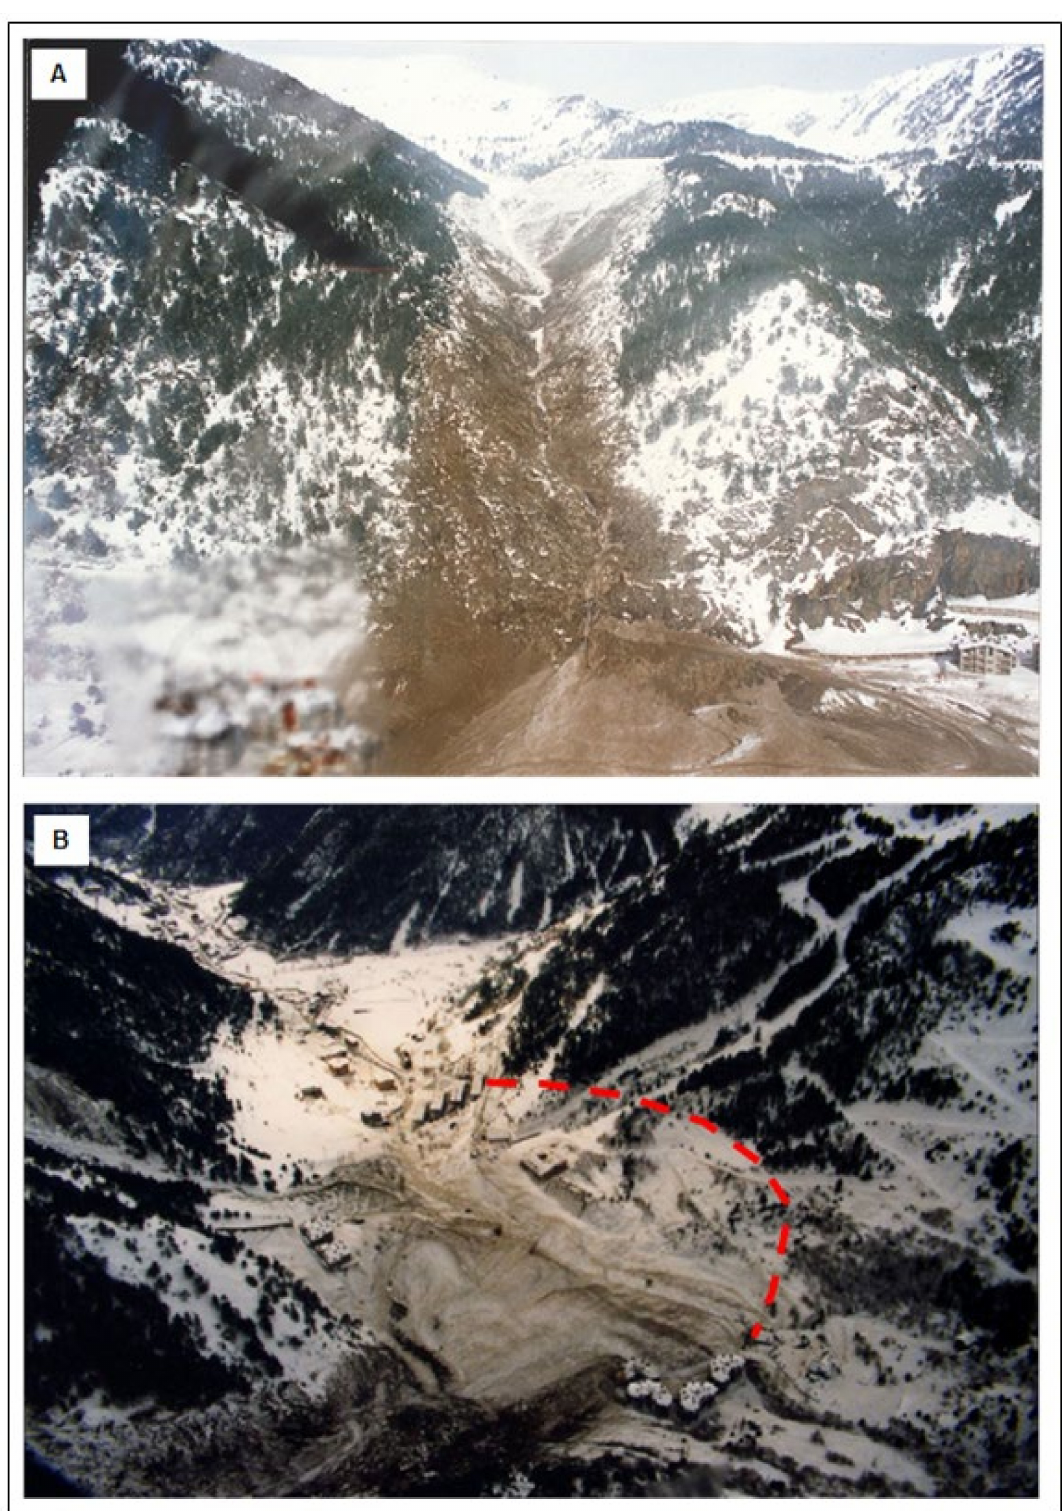
Figure 8. Photographs of the avalanche showing ( A ) the LFd’A track zone after the pure powder avalanche of 8th February 1996 (photo: A. Reyes); ( B ) the run-out zone, whose destructive limits can be mostly mapped by observing the damaged forest (red dashed line) (photo: Dept. d’Ind ú